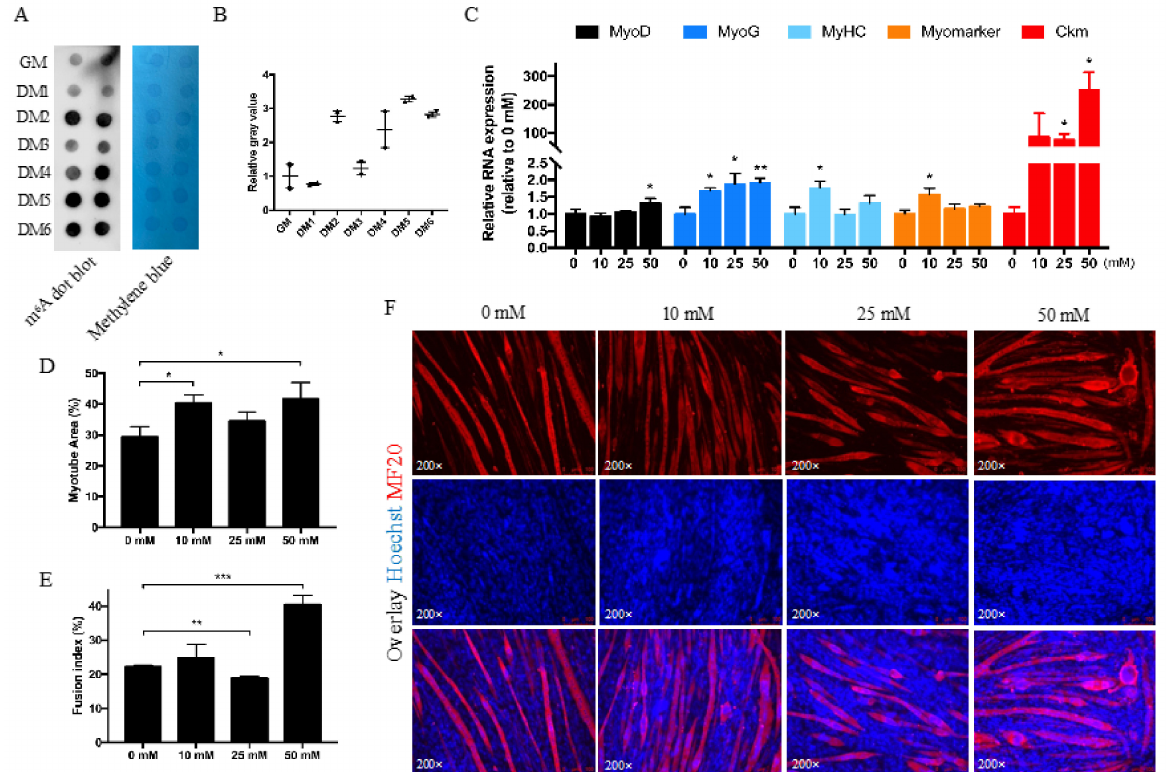
Figure 2. Betaine promotes myotube formation. ( A ) RNA dot blot and methylene blue results during myoblast differentiation. ( B ) The relative gray value of RNA dot blot. ( C ) qRT-PCR results for MyoD , MyoG , MyHC , Myomarker , and Ckm in myoblast cells after being treated with 0, 10, 25, 50 mmol/L betaine for 24 h. ( D – F ) Myotube area (%) analysis ( D ), fusion index € of MF20 immunofluorescence staining ( F ) after being treated with 0, 10, 25, 50 mmol/L betaine for 24 h at DM3. (mM refers to mmol/L; * p < 0.05; ** p < 0.01; *** p <